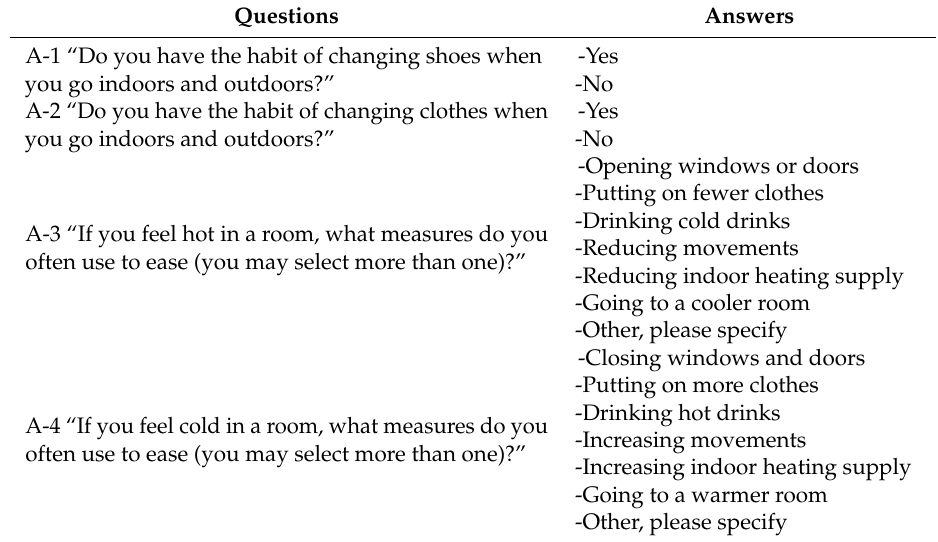
Table A1. Summary of questions in the “personal basic information and living habits in winter” survey.